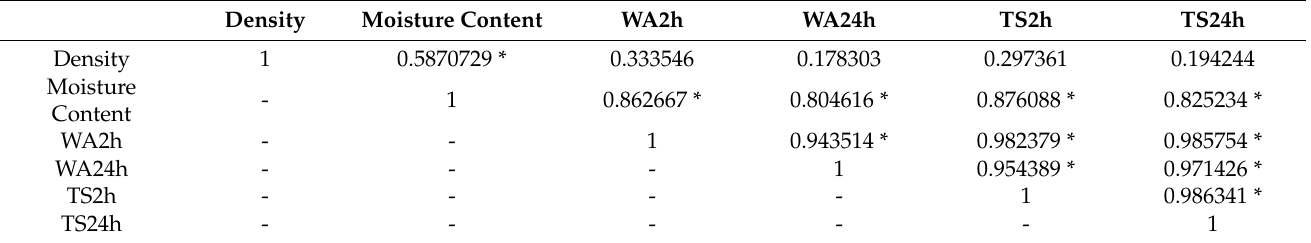
Table 5. Pearson correlation for physical properties of panels manufactured by hot pressing.